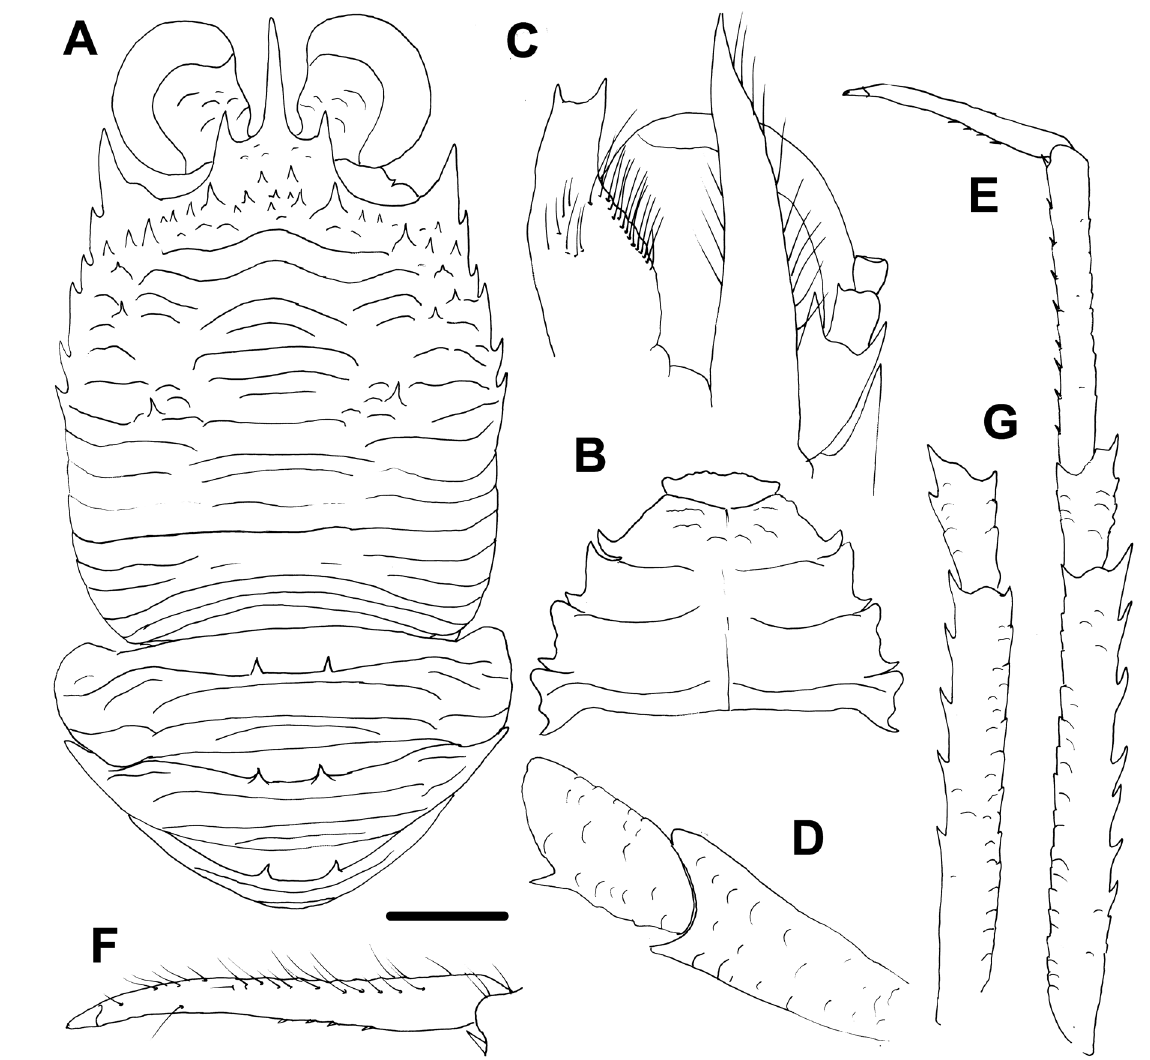
Fig. 5. Torbenella mensae sp. nov., holotype, ♂, CL = 7.2 mm (MNHN-IU-2016-3004), Papua-New Guinea. A . Carapace and abdomen, dorsal view. B . Sternal plastron. C . Cephalic region, showing antennular and antennal peduncles, ventral view. D . Left Mxp3, lateral view. E . Left P2, lateral view. F . Dactylus of left P2, lateral view. G . Right P3, lateral view. Scale bar: A–B, E, G = 2.0 mm; C–D, F = 1.0